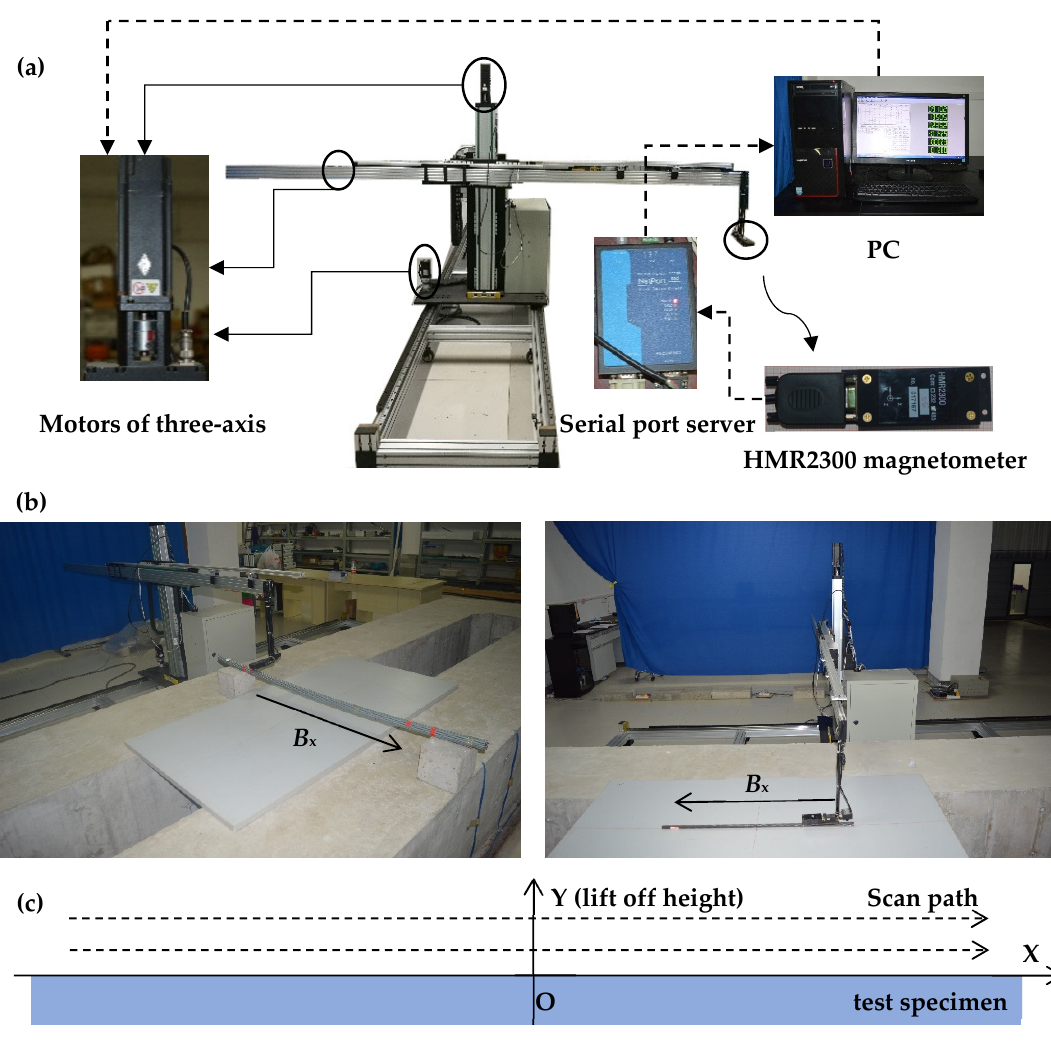
Figure 16. Magnetic signal acquisition system and acquisition path: ( a ) the composition of magnetic signal acquisition system; ( b ) the picture of magnetic signal acquisition of specimens in situ; ( c ) the Schematic diagram of magnetic signal acquisition path. B x : the magnetic flux component of x direction